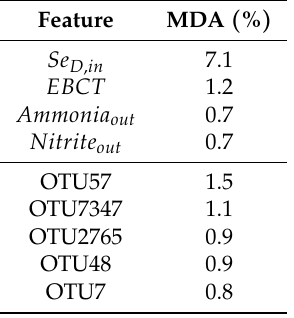
Table 6. MDA feature importances for Gaussian